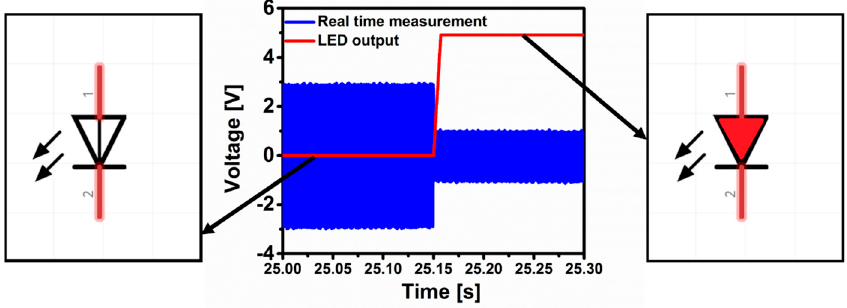
Figure 6. Time history of the sensor to trigger a LED upon water vapor exposure.